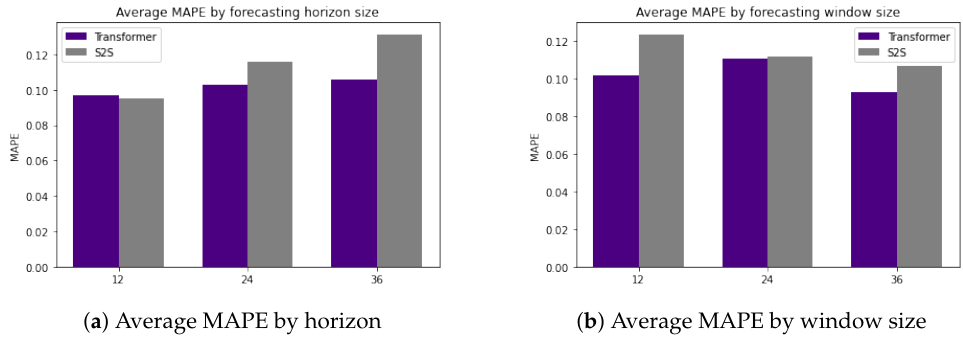
Figure 8. Comparisons of average MAPE between the transformer model and S2S